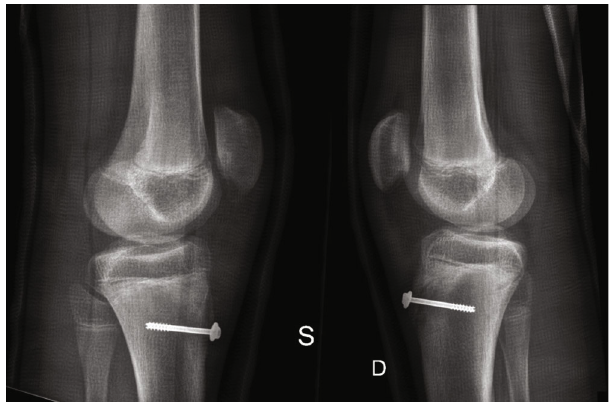
Figure 4: Showing case II post-operative result at week